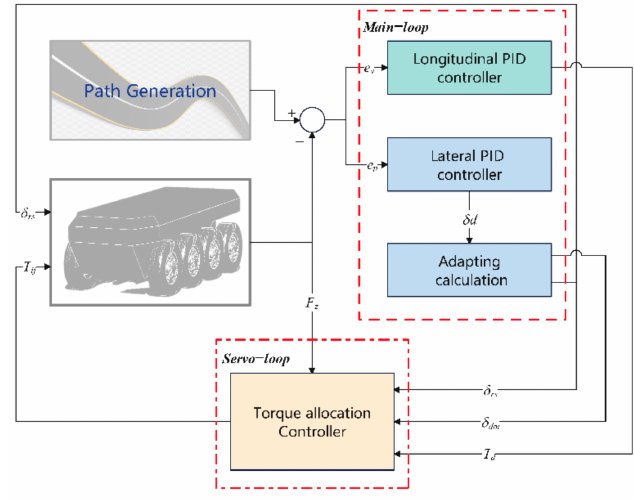
Figure 1. Diagram of the overall control scheme.